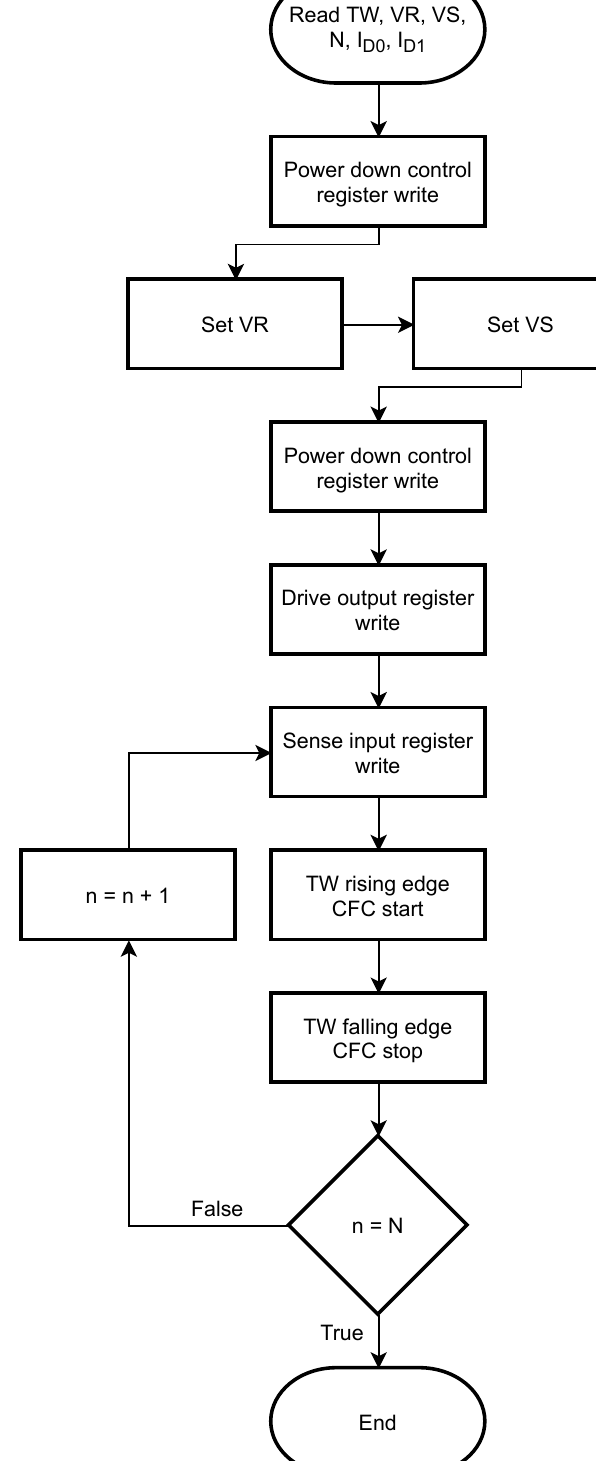
Figure 7. Flowchart of an example when measuring a